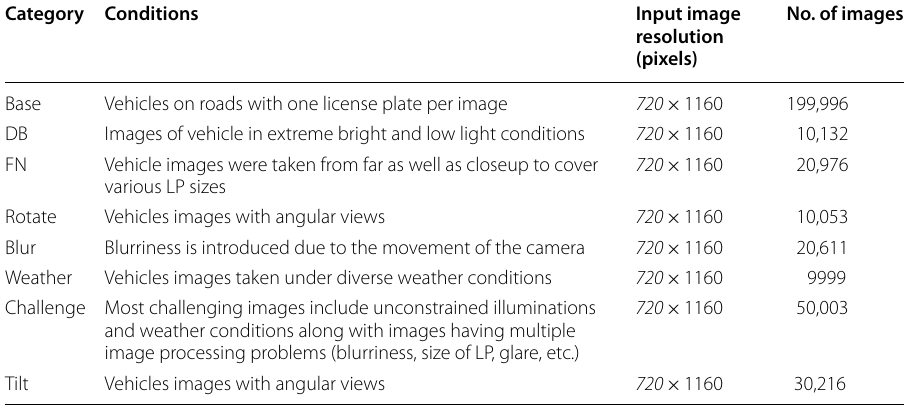
Table 2 Description of the CCPD dataset